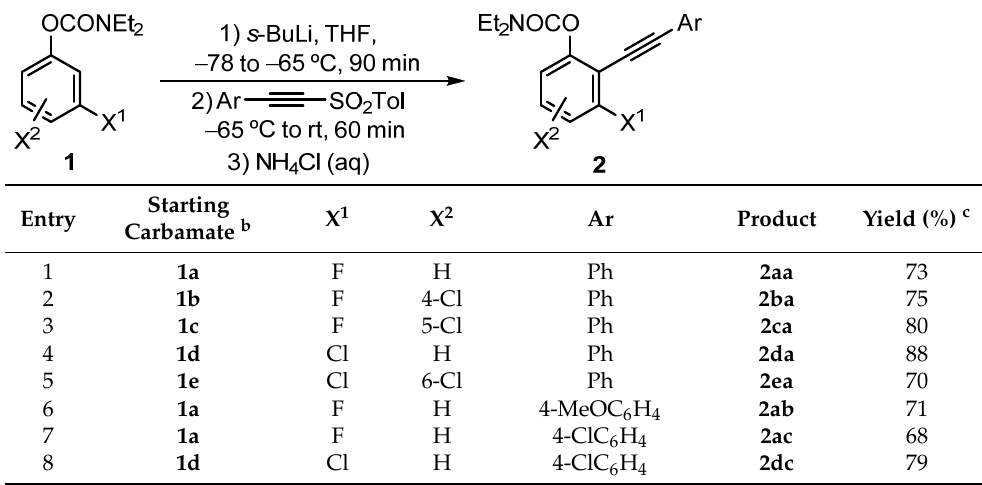
Table 1. Synthesis of O -2-alkynylaryl N,N -diethyl carbamates 2 a .